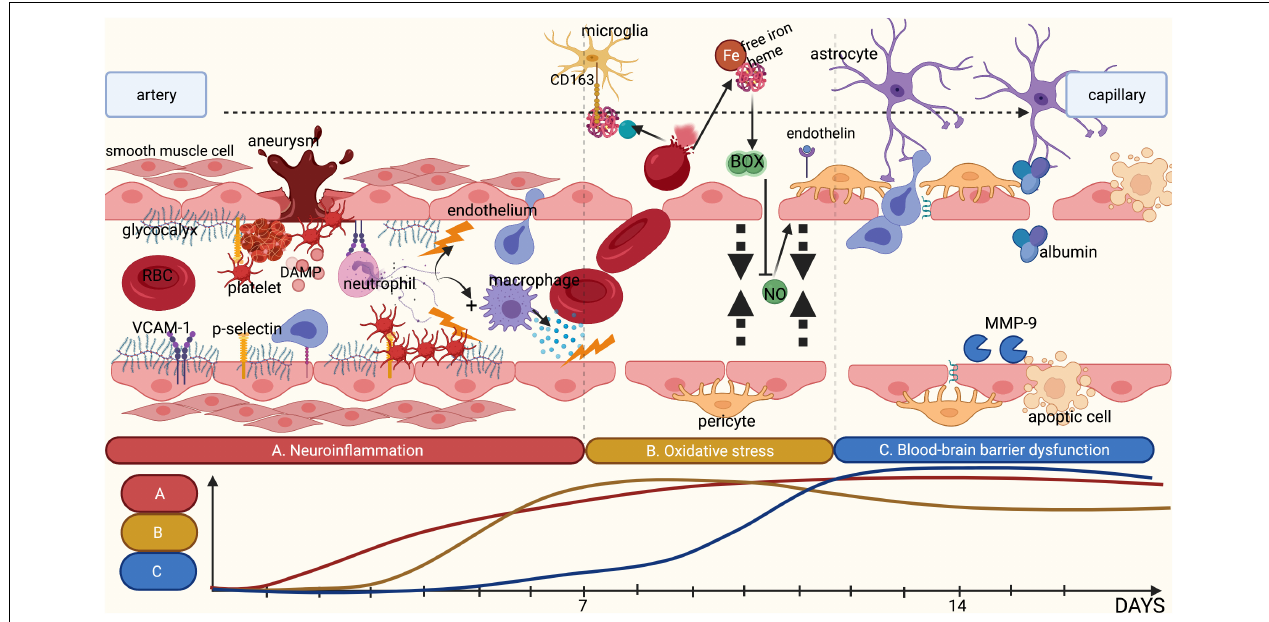
FIGURE 3 | Summary of the different pathophysiological phases contributing to DCI. (A) Rupture of an intracranial aneurysm is associated with tissue damage and subsequent tissue ischemia, releasing DAMPs. This release attracts leucocytes such as neutrophils, thereby initiating local neuroinflammation. Combined with an increase in shear stress, rupture of an intracranial aneurysm is likely to damage the glycocalyx. This loss of glycocalyx integrity promotes adhesion of platelets and neutrophils to the endothelium by cell-adhesion molecules and selectins, which are no longer covered by the glycocalyx. The adhered inflammatory cells release cytokines, further stimulating local neuroinflammation. (B) Following rupture of an intracranial aneurysm, red blood cells (RBCs) enter the subarachnoid space wherein they undergo lysis, resulting in the release of free iron and heme. Under physiological conditions, haptoglobin and hemoglobin form a complex that binds microglia and macrophages through the membrane receptor CD163 for phagocytosis. However, following the rupture of an aneurysm, the copious amounts of RBC lysis products quickly saturate haptoglobin, leaving free iron unbound. Following oxidation, free iron results in the synthesis of reactive oxygen species and subsequently in reduction of the availability of nitric oxide. Moreover, the disrupted glycocalyx has a reduced synthesis capacity for nitric oxide in response to shear stress. This leads to an absolute shortage in nitric oxide, limiting vasodilatory capacity. In addition, endothelin-1 is no longer inhibited by endothelial nitric oxide leading to increased vasoconstriction. (C) The above-mentioned processes promote blood-brain barrier (BBB) disruption. Products of RBC lysis activate microglia, which in turn release additional cytokines. Activated neutrophils and macrophages entering the subarachnoid space also release inflammatory cytokines and matrix metalloproteinases, disrupting the extracellular matrix and the basement membrane, leading to increased BBB permeability. This is further aggravated by the disruption of the glycocalyx that can no longer exert its barrier functions. Finally, this results in the formation of local oedema, inflammation and ischemia. Image is created using